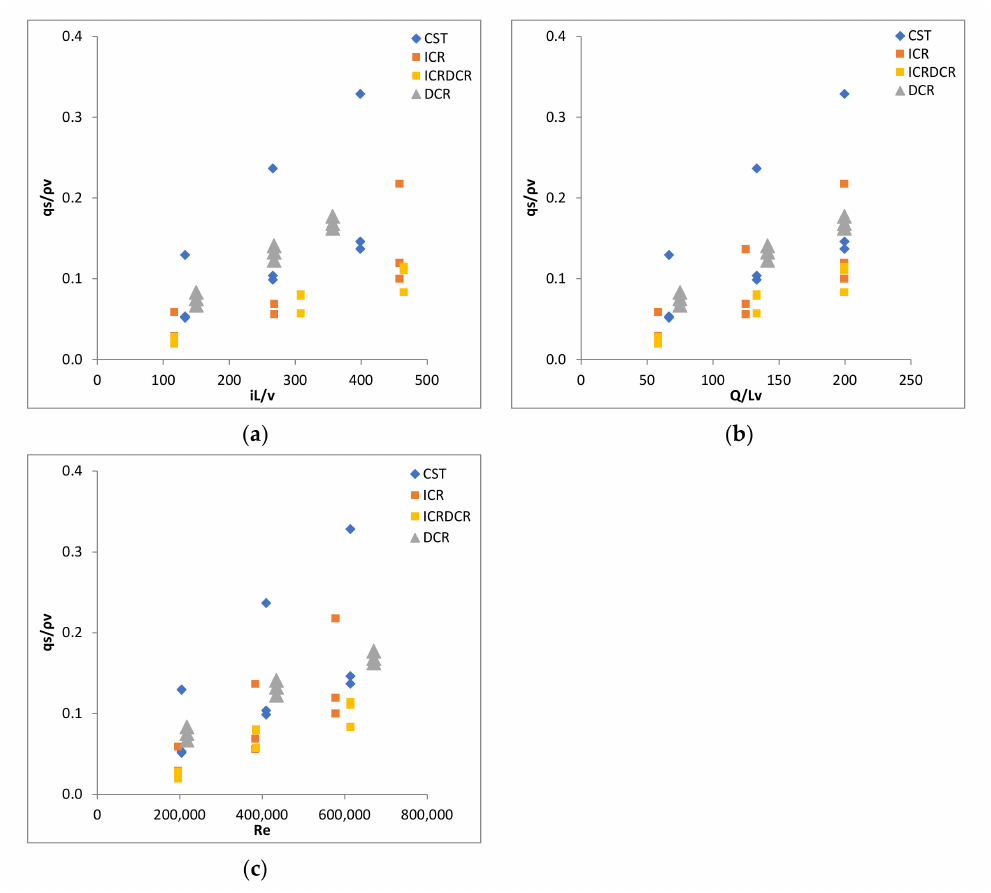
Figure 2. Relationship of dependent parameter, q s